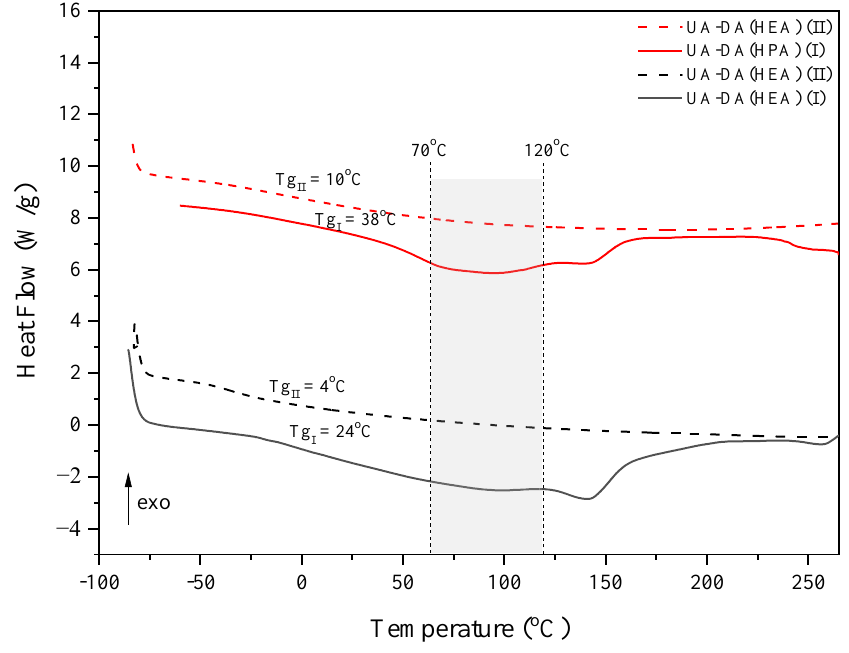
Figure 8. DSC curves during two heating cycles for the UV-cured UA-DA films.